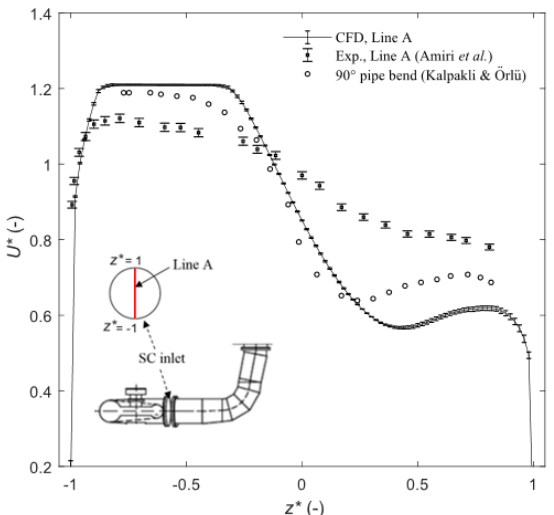
Figure 5. Normalized streamwise velocity ( U ∗ ) profile along Line A, with discretization error bars for the chosen (fine) mesh in the study. z* is the dimensionless vertical distance in the spiral casing. The velocities are scaled by the bulk velocity ( Q BEP / A SC_inlet ). Experimental data for Line A is from Amiri et al. [26], with the error bar assumed to 1% of the value which is reasonable for LDA measurements. The data from Kalpakli and Örlü [38] is for a 90 ◦ pipe bend measured with a